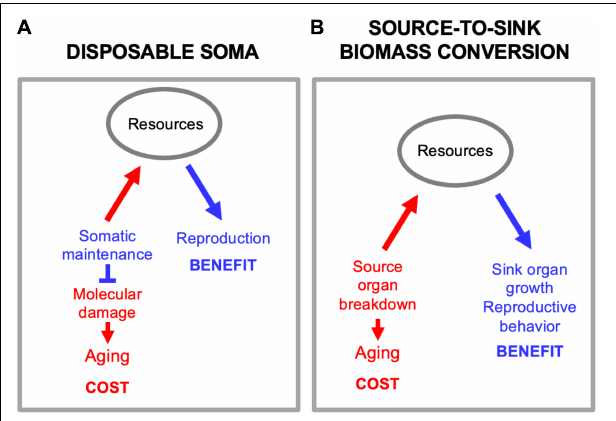
FIGURE 5 | Source-to-sink biomass conversion is not disposable soma. (A) Disposable soma. Here a primary cause of aging is stochastic molecular damage accumulation, prevented by somatic maintenance processes. Diversion of resources from somatic maintenance to reproduction provides a reproductive fitness benefit, but allows molecular damage to accumulation, causing aging. (B) Source-to-sink biomass conversion. Here a primary cause of aging is programmatic, active self-destruction of organs to release resources for